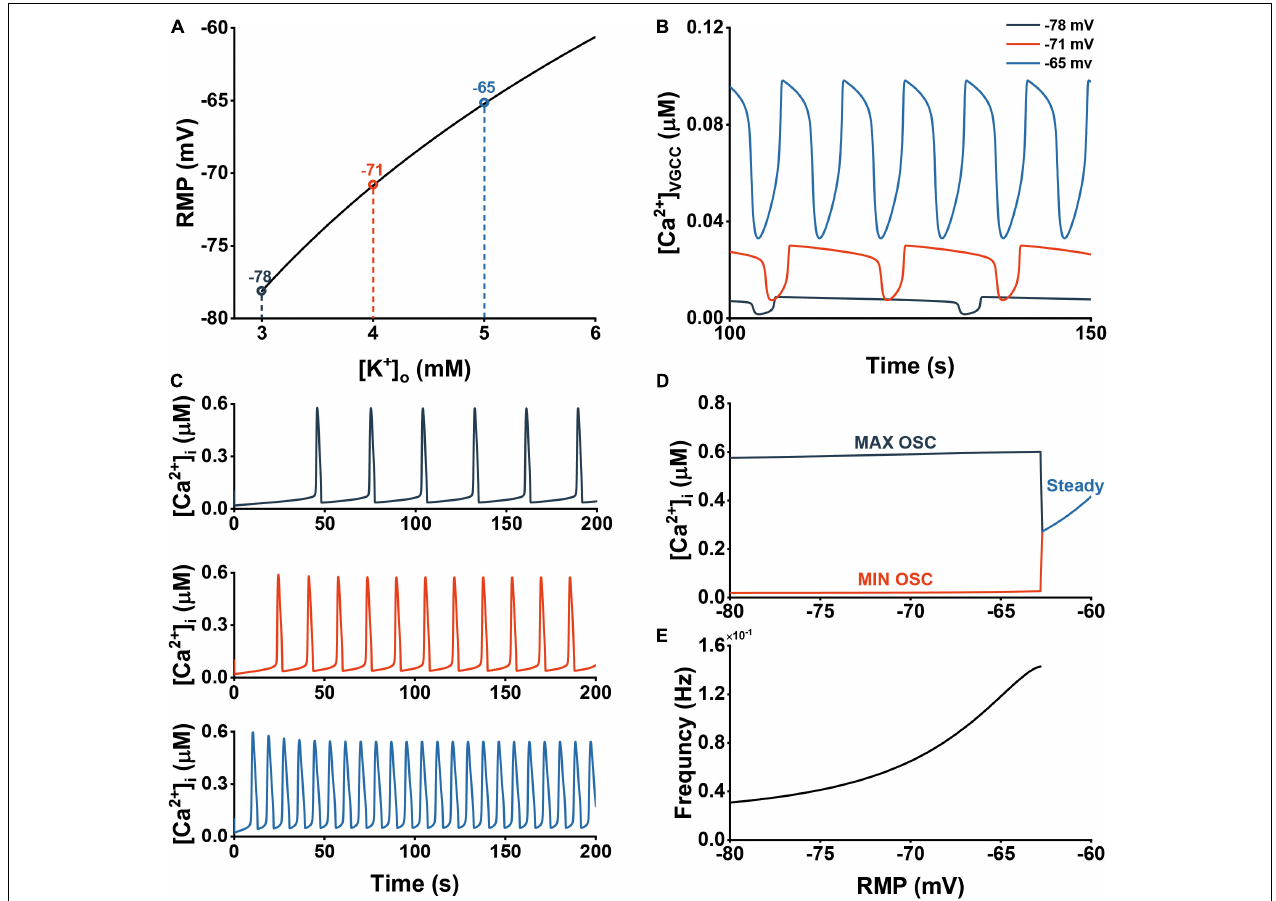
FIGURE 5 | Extracellular K + increases the frequency of Ca 2 + oscillations through activation of VGCCs. (A) The dependency of the astrocytic RMP V m of different [ K + ] o . (B) Ca 2 + influx through VGCCs at three different RMPs (–78, –71, and –65 mV). (C) Cytosolic Ca 2 + dynamics at three different RMPs (–78, –71, and –65 mV). (D) Bifurcation diagram of the [Ca 2 + ] i in cytosol vs. RMP. (E) The frequency of the oscillations vs.